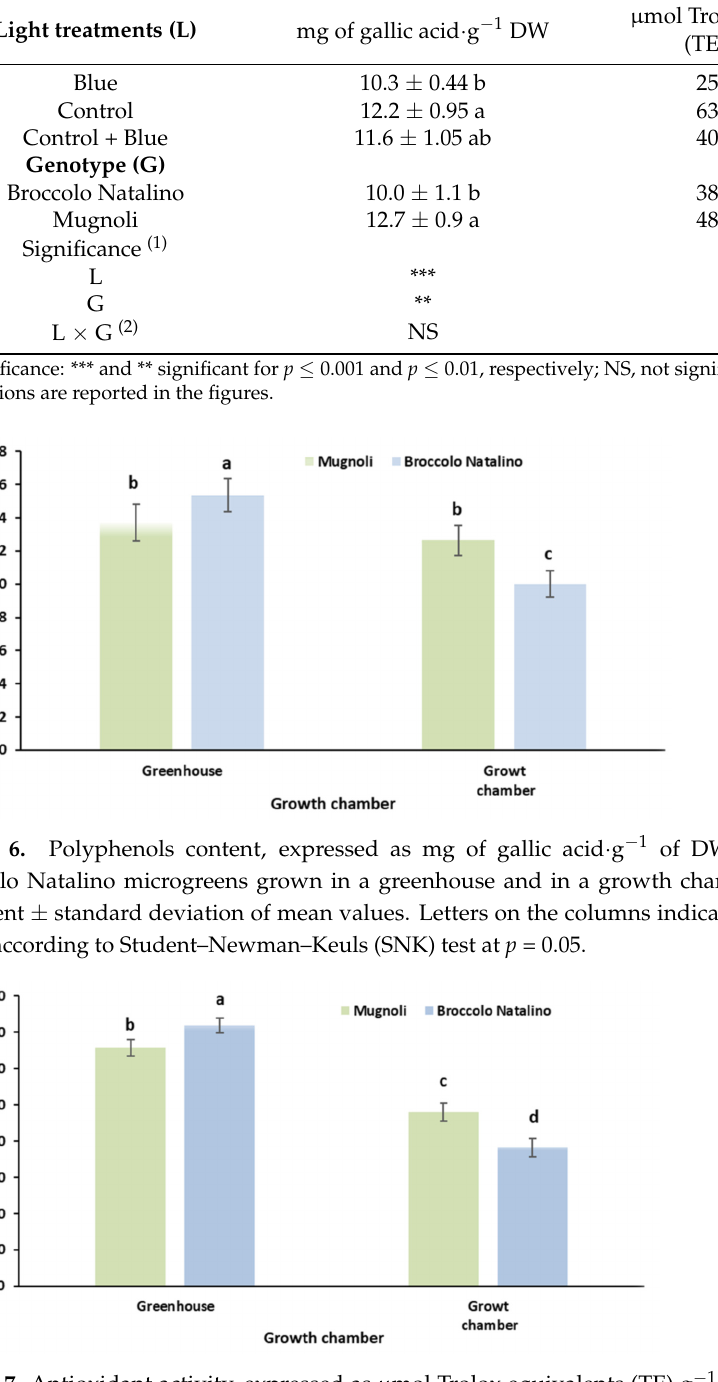
Figure 7. Antioxidant activity, expressed as µ mol Trolox equivalents (TE) g − 1 of DW, of Mugnoli and Broccolo Natalino microgreens grown in a greenhouse and in a growth chamber. Vertical bars represent ± standard deviation of mean values. Letters on the columns indicate significant differences according to Student–Newman–Keuls (SNK) test at p = 0.05.